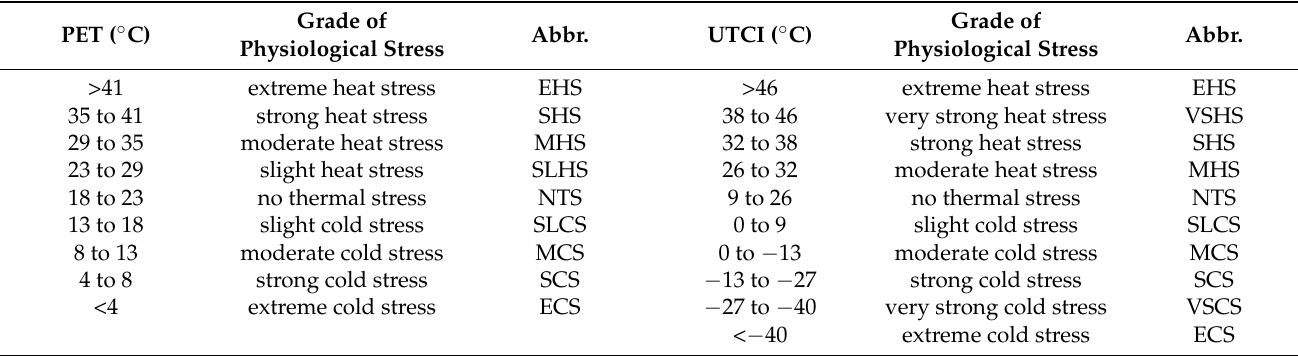
Table 1. Thermal perception and stress classification of Physiological Equivalent Temperature (PET) [31] and Universal Thermal Climate Index (UTCI) [65]. PET ( ◦